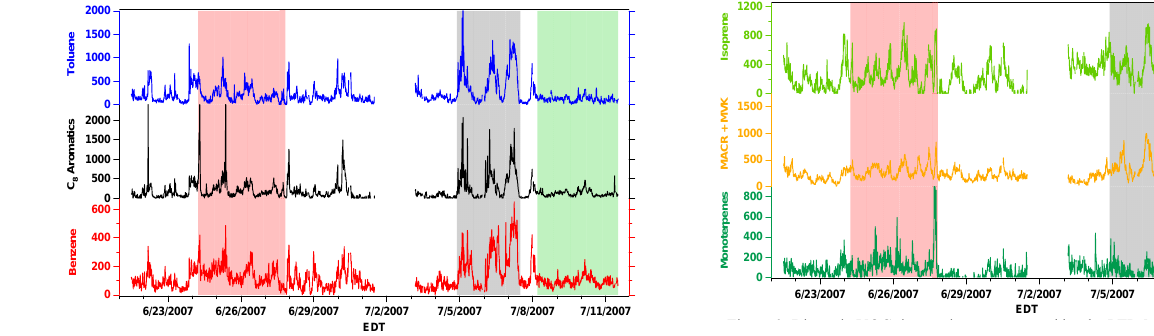
Figure 2. Aromatic VOC time series, as measured by the PTR-MS. Units are in pptv. Red, black and green shaded periods refers to different air mass episodes: Processed Air, Detroit Air, and Sulfate and Biogenic Air, respectively.